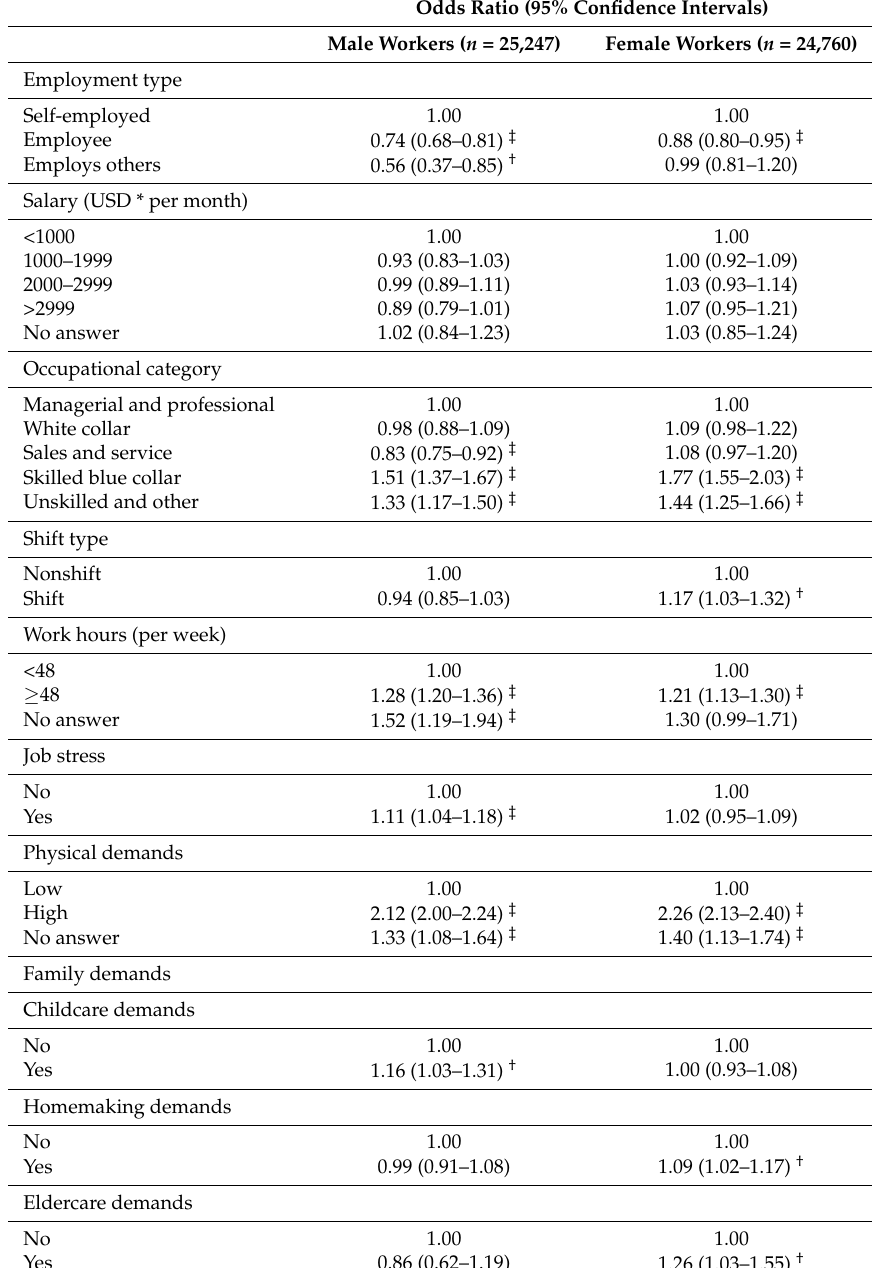
Table 3. Associations among family demands, WLC, and MSDs in the past 12